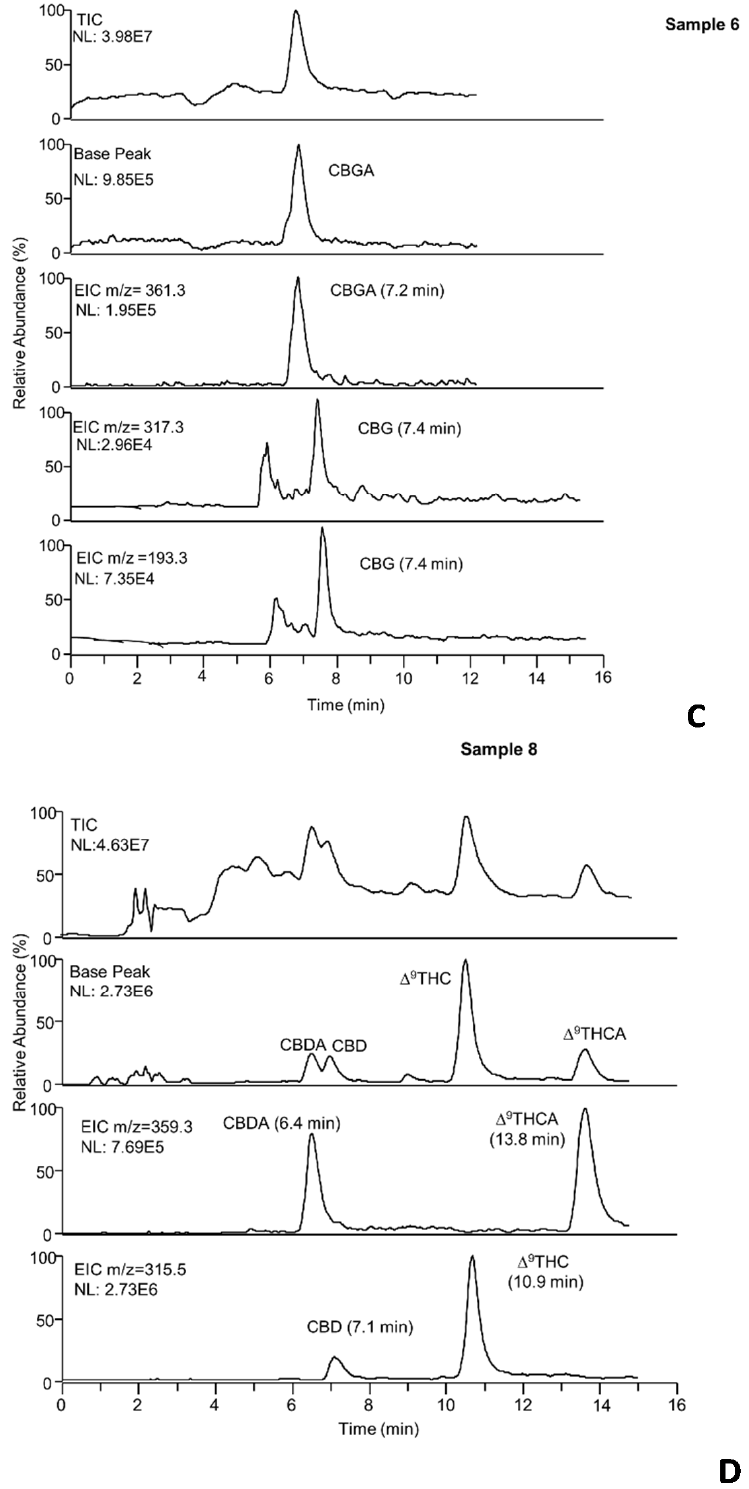
Figure 5. ( A – D ) Total ion, base peak and extracted ion chromatograms of the hemp extracts. Ex- perimental conditions: capillary column, packed with ChromSpher C18 for 15 cm, effective length 22 cm, mobile phase, ACN/H 2 O/formic acid, 80/19/1% ( v/v / v ); injection time, 30 s; flow rate, 550 nL/min. For MS parameters, see Section 3.2. The hemp extracts analyzed were subjected to a DM extraction procedure.